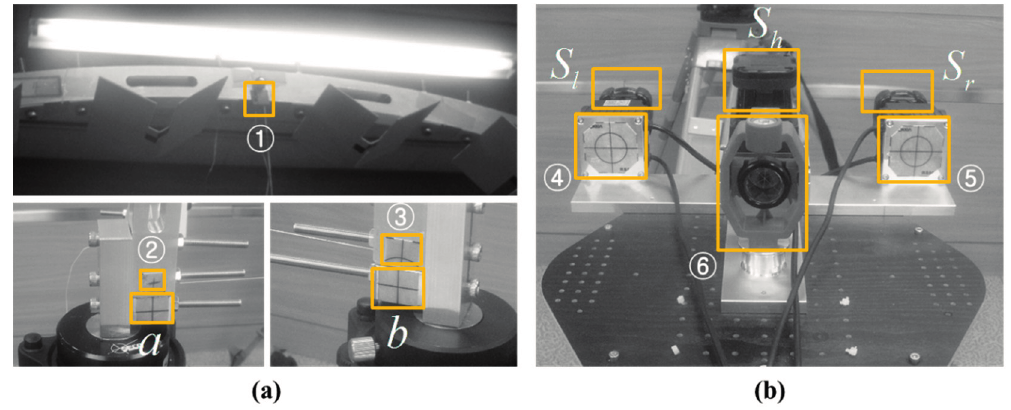
Figure 9. Total station measurement targets and LRF sensors ( a ) on the aluminum frames and ( b ) on the platform